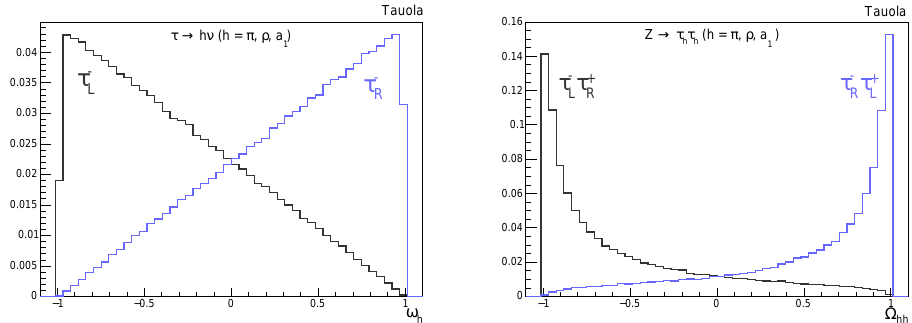
( Left ) and Ω ( Right ) for negative (black) and h hh